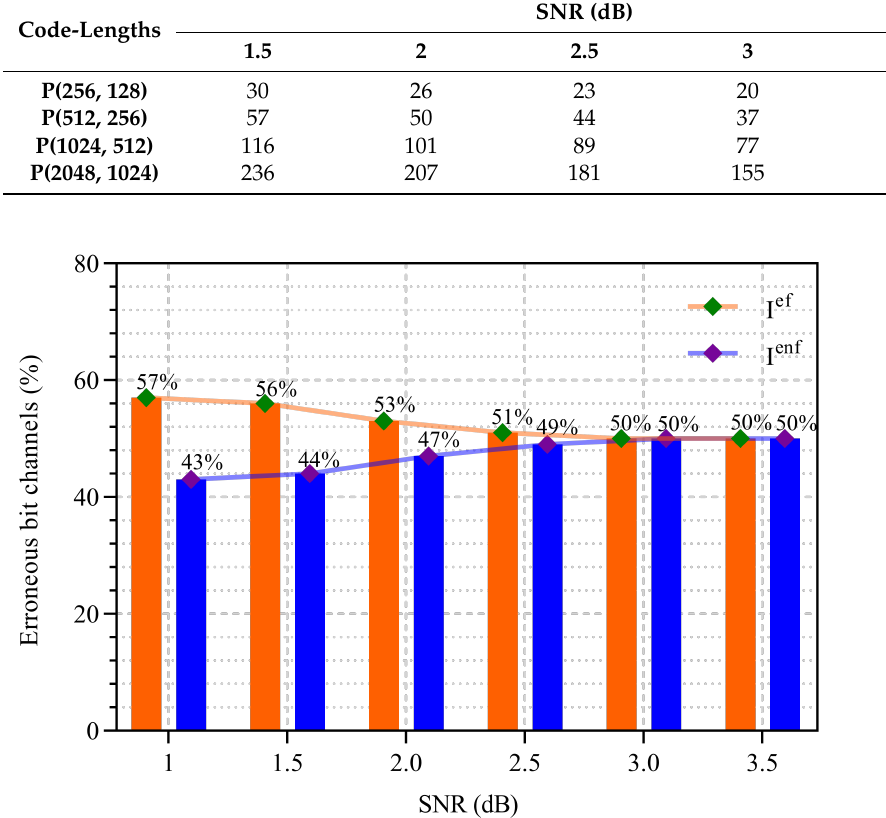
Figure 2. Histogram of erroneous channels with N = 256 and R = 1/2 at different signal-to-noise ratios (SNRs) for 10 7